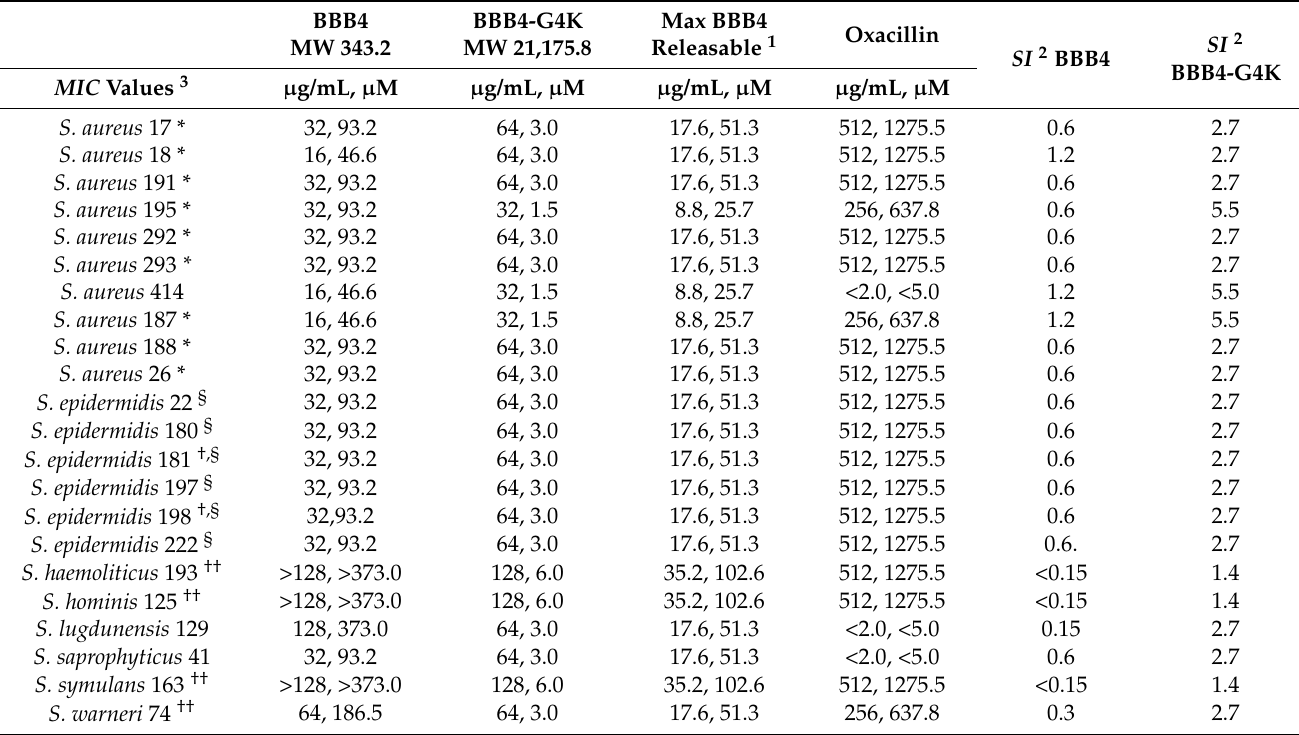
Table 3. MICs of BBB4-G4K NPs, expressed as µ g/mL and micromolarity ( µ M), against the Staphy- lococcus species tested in the study; the relative maximum concentrations of BBB4 that should be released by BBB4-G4 NPs according to the observed MICs; and the relative DL% and the release profile [16]. The MICs of pristine BBB4 were also reported. The last two columns report the values of selectivity indices ( SI ) of BBB4 and BBB4-G4K